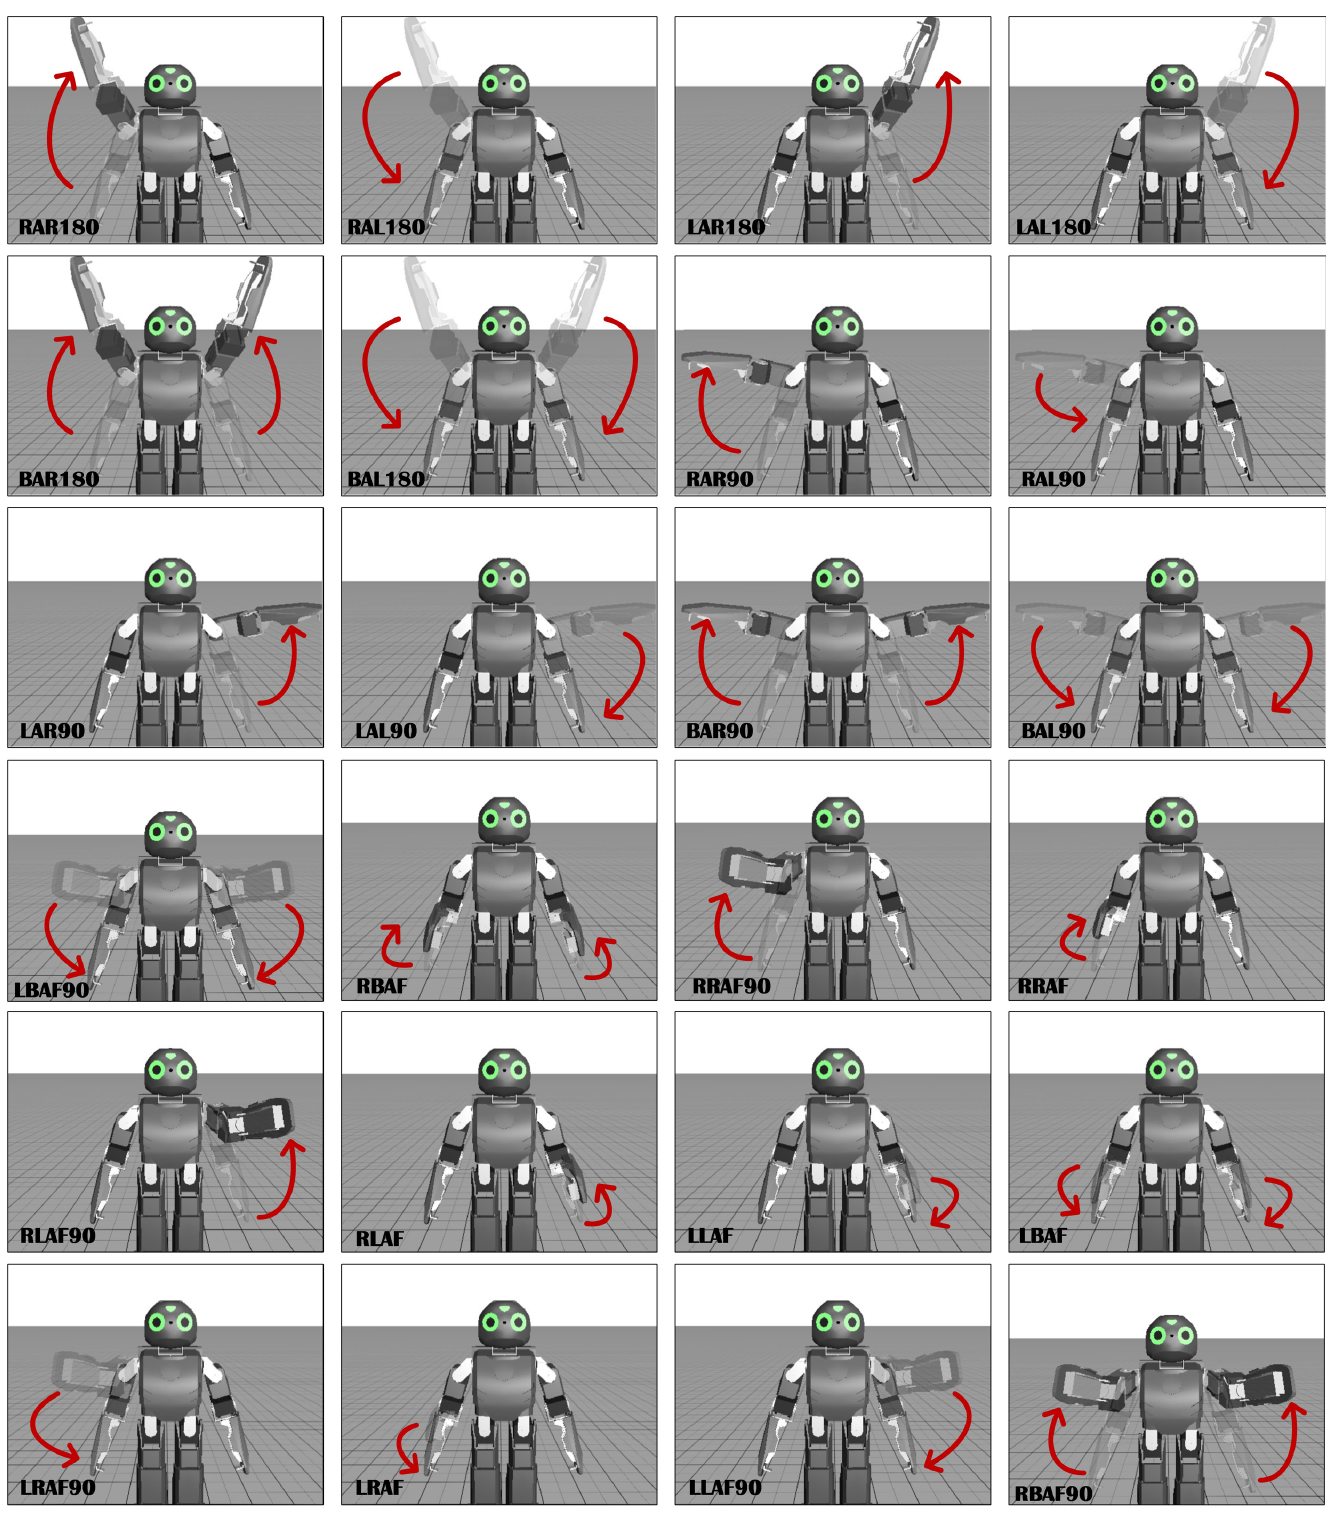
Fig 9. Different samples of actions performed by the robot during